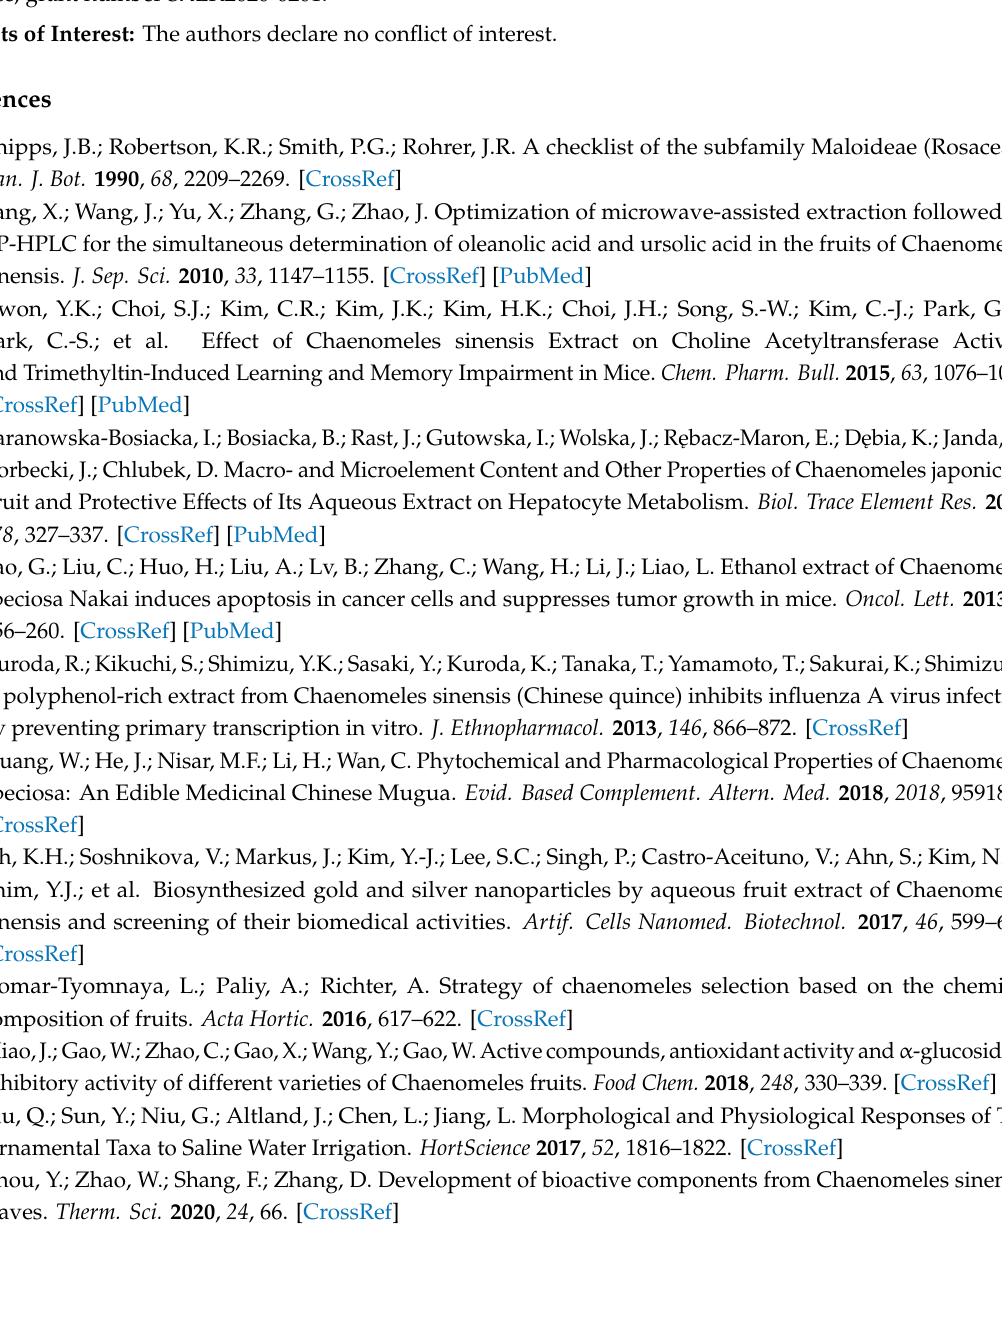
Supplementary Materials: The following are available online. Figure S1: Clustering heat map of all flavonoid metabolites; Figure S2: di ff erential flavonoid metabolites in di ff erent comparison group; Figure S3: The stacking diagram of total ions current (TIC) maps from quality control samples (QC) mass spectrometry. Figure S4: MS / MS spectra of some metabolites. Table S1: A list of the 179 metabolites detected in this study; Table S2: The screening results of di ff erential flavonoid metabolites; Table S3: KEGG annotated results of di ff erential flavonoid